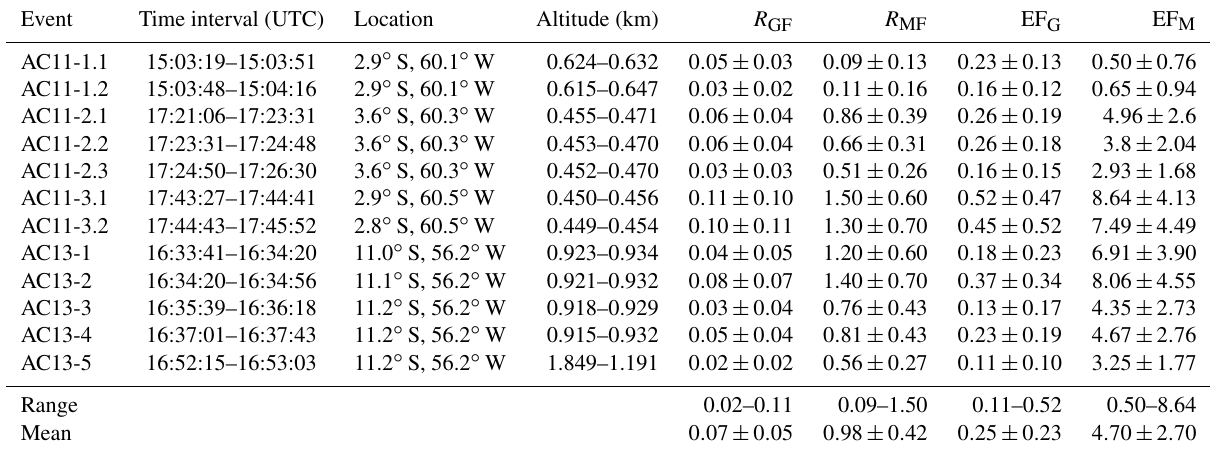
Table 3. Inferred normalized excess mixing ratios and emission factors for individual biomass burning events (range and mean). R GF and R MF are given in moles per mole. The emission factors EF G and EF M are in units of grams per kilogram. Event Time interval (UTC)